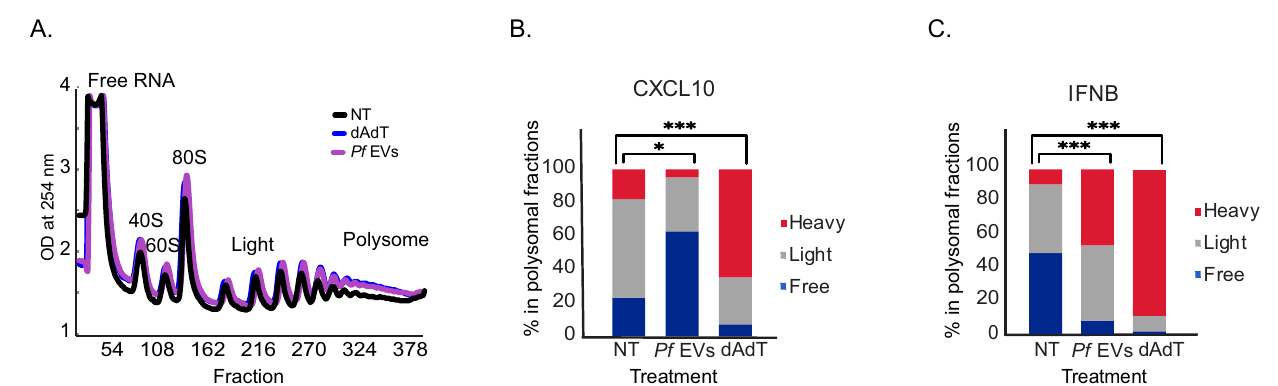
Fig. 2 Pf -derived EVs inhibit the translation of CXCL10. A Polysomal pro fi ling of THP-1 cells 14 h post transfection with poly(dA:dT) (blue), Pf – derived EVs (purple), or not treated (NT) (black). One representative repeat out of fi ve biological replicates is shown. B . THP-1 cells were incubated with Pf -ring- stage-derived EVs or transfected with poly(dA:dT) for 14 h or NT. Polysomal pro fi ling was performed on all samples and RNA was isolated from heavy, light and free fractions. Real-time PCR for CXCL10 was performed on all the polysome fractions. n = 3 biologically independent experiments, NT (not treated) THP-1 cells were used as control. One-way ANOVA followed by Dunnett ’ s test for the heavy fractions (dAdT - NT *** P = 1.64e-05, Pf EVs - NT * P = 0.0368). C . THP-1 cells were incubated with Pf -ring-stage-derived EVs, transfected with poly(dA:dT) for 14 h or NT. Ribosomal pro fi ling was performed on all samples and RNA was isolated from heavy, light and free fractions. Real-time PCR for IFNB was performed on all the polysome fractions. n = 3 biologically independent experiments. One-way ANOVA followed by Dunnett ’ s test for the heavy fractions (dAdT - NT *** P = 3.23e-05, Pf EVs - NT *** P = 0.000543). Source data are provided as a Source Data fi